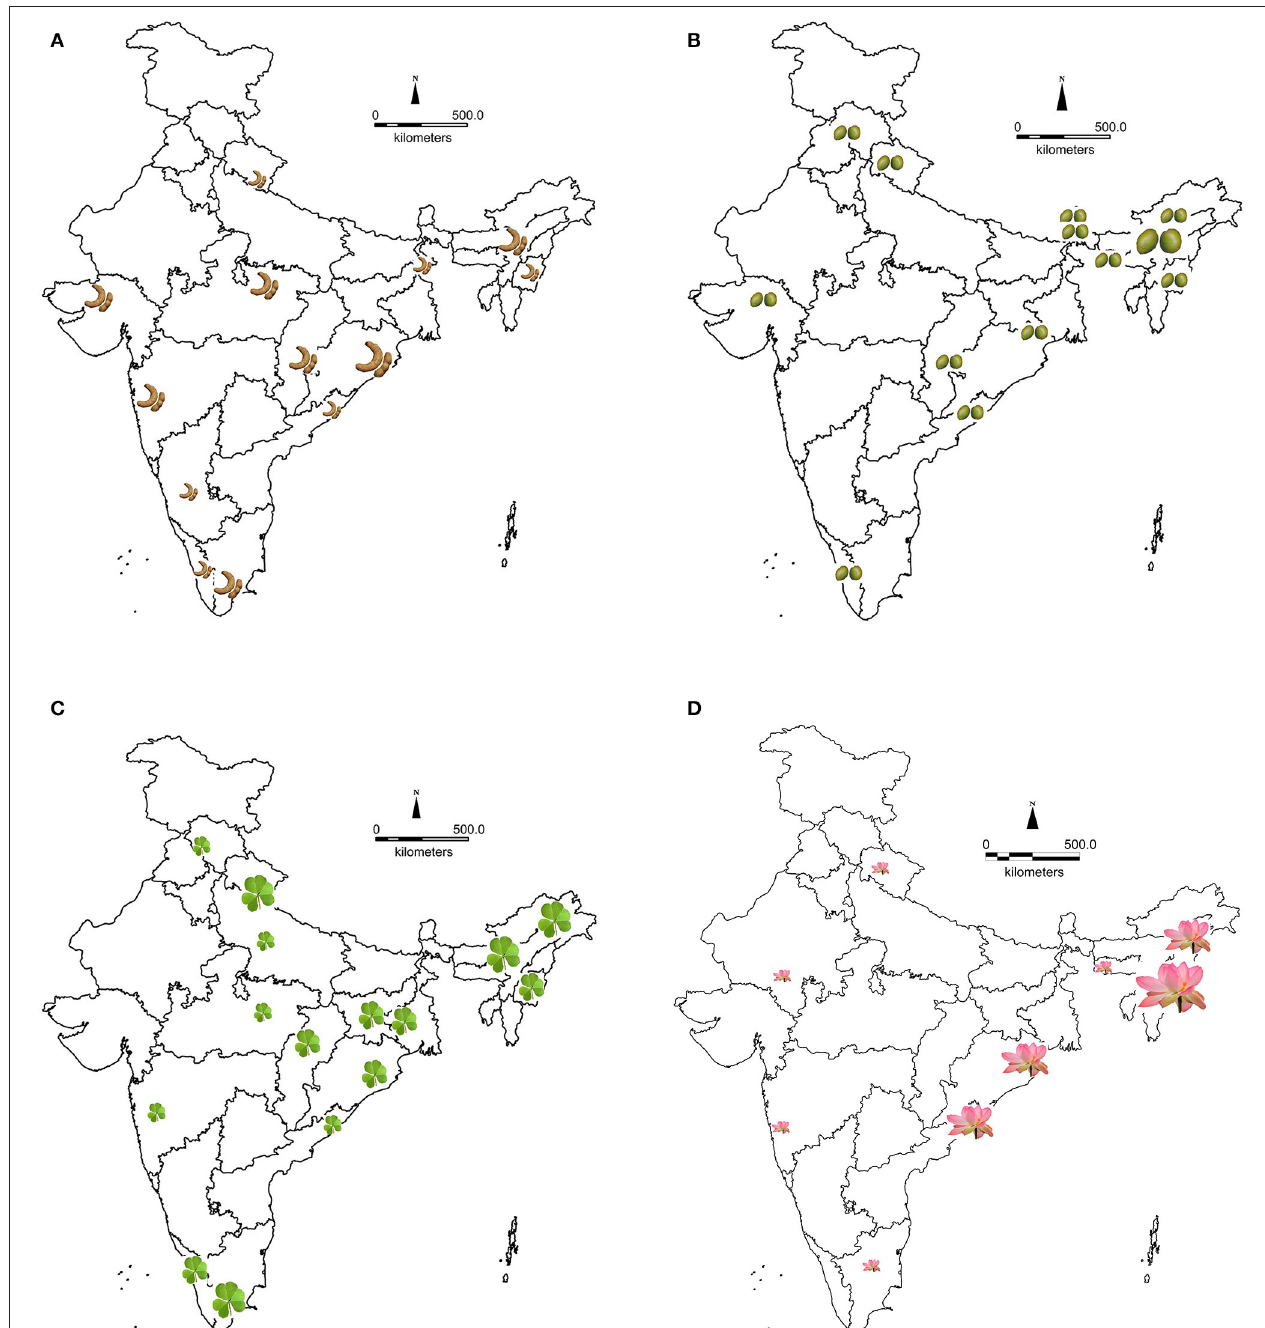
FIGURE 5 | Spatial distribution of a few prioritized species: species with higher RFC and RUV (dots represent spatial distribution and dot size is proportional to the number of plant part use)— (A) Tamarindus indica and (B) Spondias pinnata ; species with higher RFC (dots represent spatial distribution and dot size is proportional to the number of papers cited from the area) (C) Oxalis corniculata ; and species with higher use value (dots represent spatial distribution and dot size is proportional to the number of plant part use) (D) Nelumbo nucifera